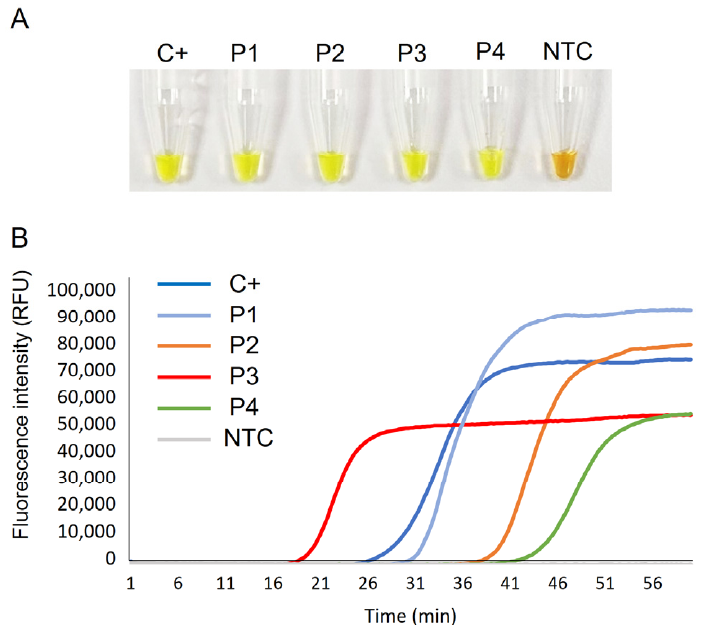
Figure 3. Clinical sample testing by CCHFV-RT-LAMP. ( A ) Colorimetric RT-LAMP results by SYBR green end-point addition. ( B ) Real-time RT-LAMP results showing EvaGreen 20 × fluorescence signal over time. C+, RNA isolate from an infected patient used as positive control (P5); P1–P4, RNA isolates from patients with CCHF; NTC, non-template control. RFU, relative fluorescence units.